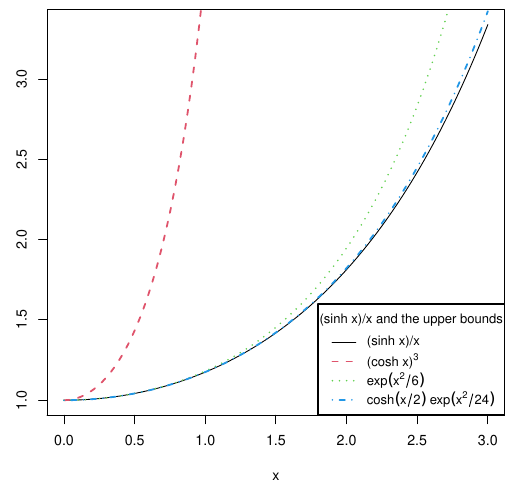
Figure 3. Visual comparison of lower bounds for (sinh x ) /x with x ∈ [0 , 3] ; the obtained upper bound is in blue color Note. Due to the symmetry of the functions involved all the inequalities which are true in (0 , δ ) are also true in ( − δ, 0)